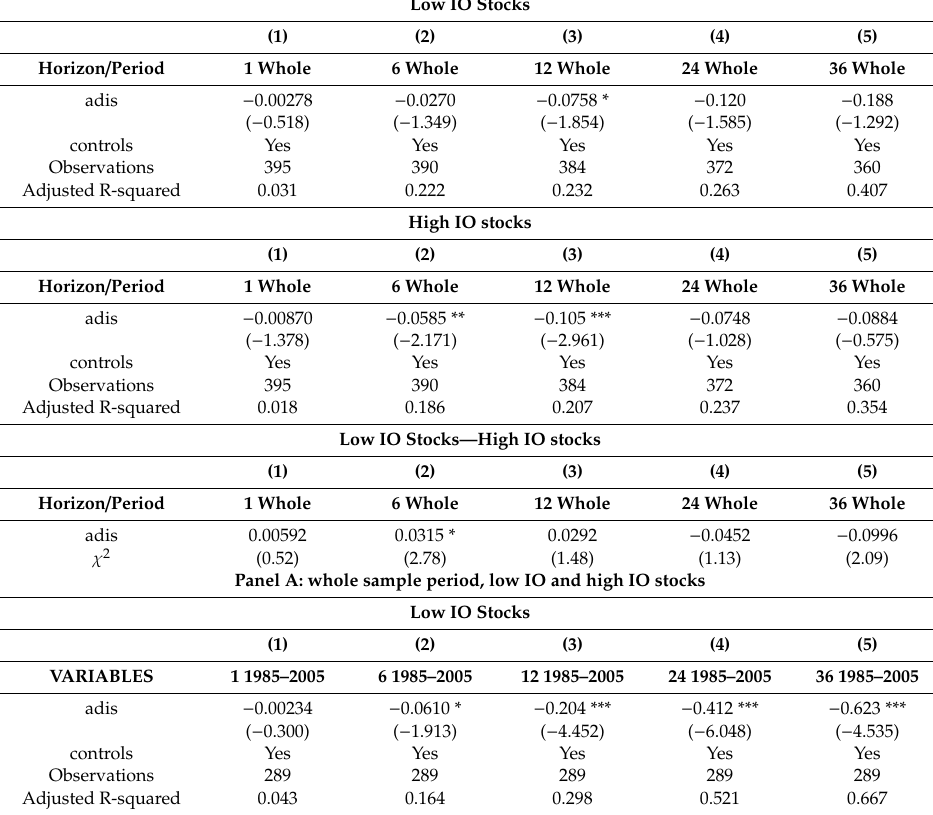
Table 8. Comparison of dispersion e ff ect between low and high IO